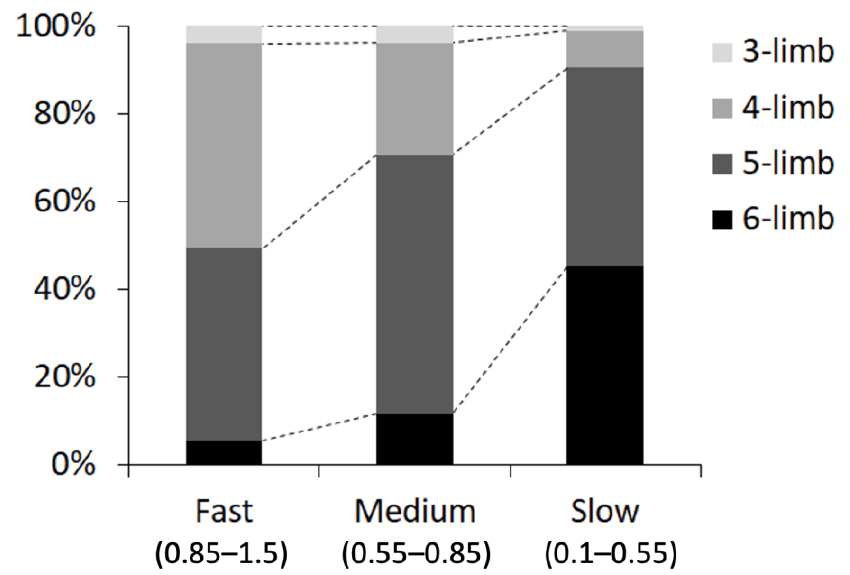
Figure 9. Proportion of each mode of leg contact (number of contact legs) at each walking speed: fast (0.85–1.5 cm/s), medium (0.55–0.85 cm/s), and slow (0.1–0.55 cm/s).